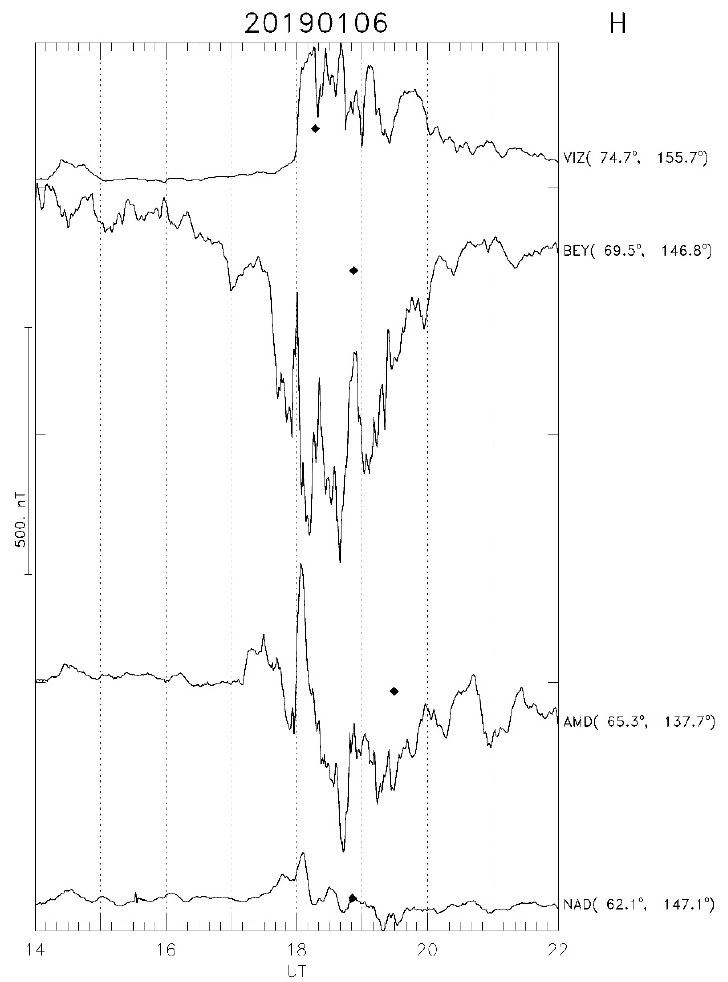
Figure 4. Magnetograms ( H component) from stations along the latitudinal profile 150 ° : VIZ-BEY- AMD-NAD during 14–22 UT on 6 January 2019. Black diamonds denote local midnight.